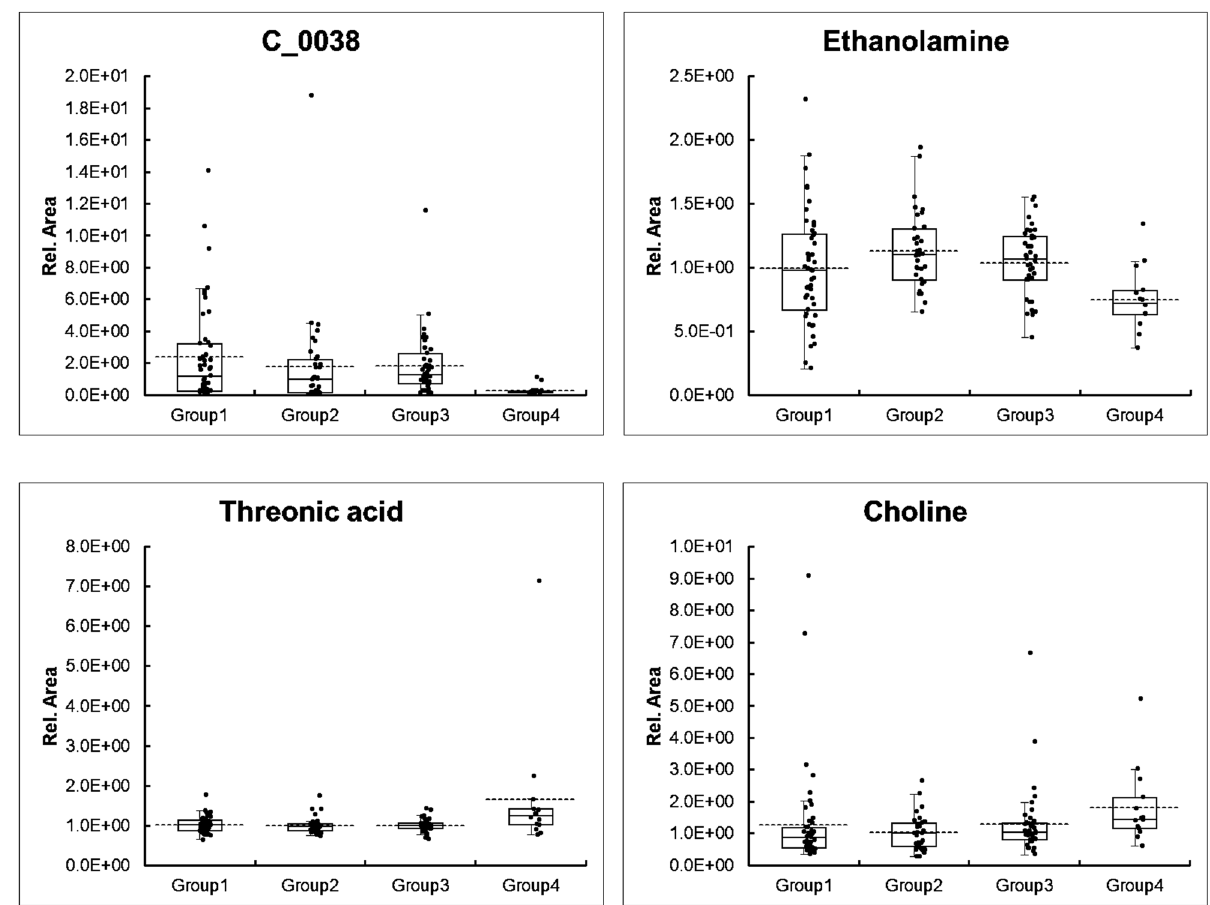
Figure 1. Representative relative MS area of promising metabolites. A point plot and box plot of four promising metabolites, C_0038, ethanolamine, threonic acid, and choline, are shown. The vertical bar shows the relative area of each metabolite. The dotted line is equal to the average. Annual eGFR change rate for each group was as follows; group1, above 0%; group 2, below 0% and above − 3.3%; group3, below − 3.3% and above − 10%, and group 4, below